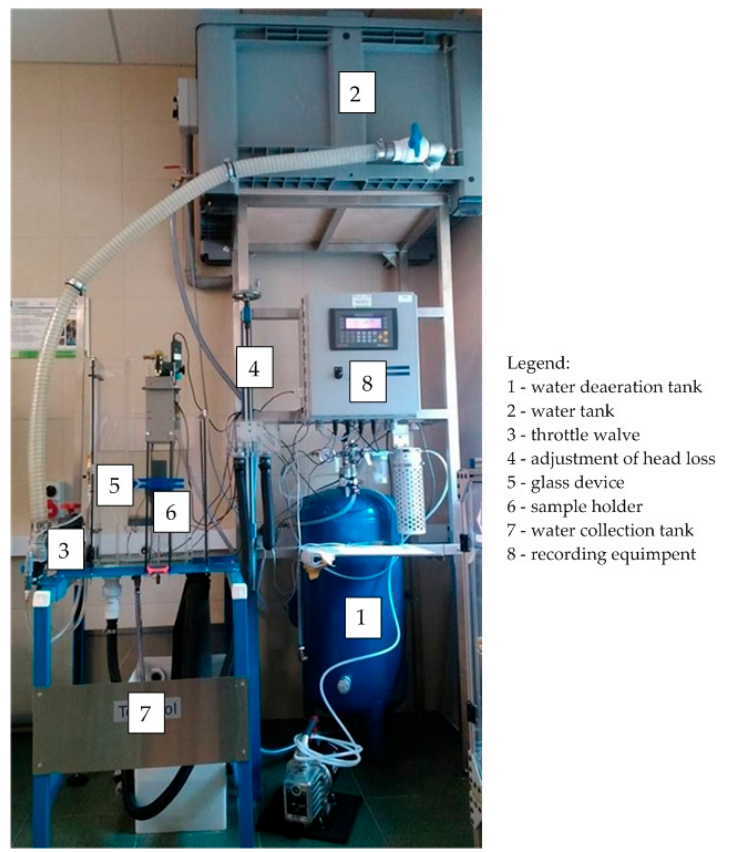
Figure 4. Laboratory equipment used for the determination of water permeability characteristics normal to the plane, without load.